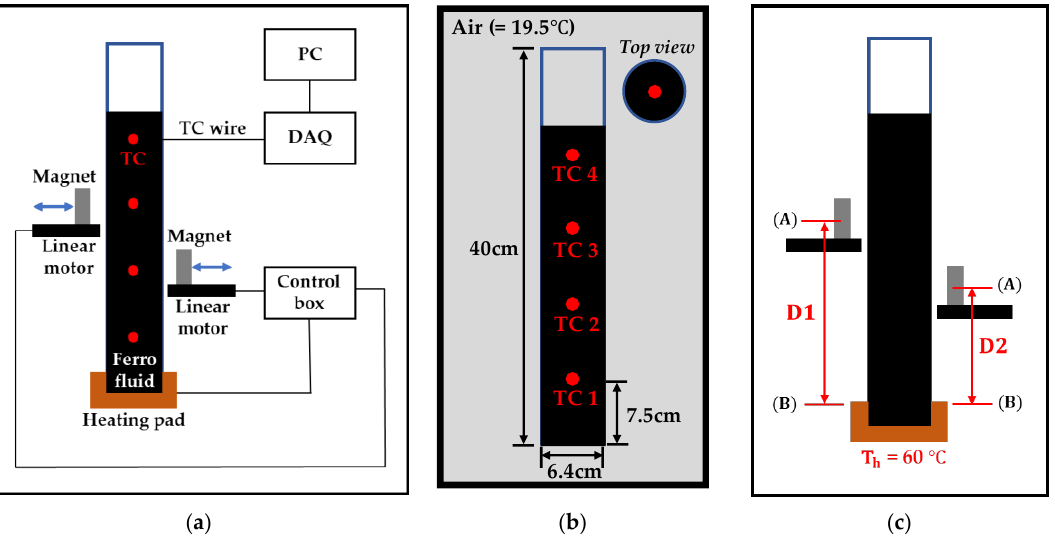
Figure 2. ( a ) Schematic of total experimental device, ( b ) Figures of Pyrex glass tube and TC wire configuration, ( c ) Parameter sets for permanent magnets.